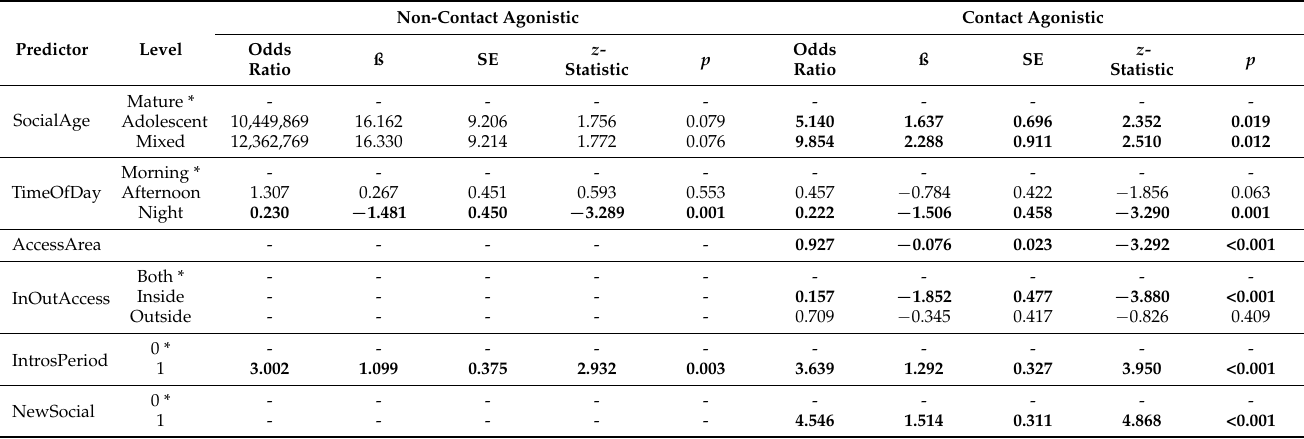
Table A8. Mature GLMER model parameter estimates for agonistic response variables. Generalized linear mixed-effect model results of associations between predictor variables (fixed effects) and behavioral response variables for mature focal animals. ß = Beta coefficients from model outputs: positive values indicate an increase in odds compared to the reference level while negative values indicate a decrease in odds compared to reference level; SE = standard error of beta coefficients; Wald X 2 = Chi-squared statistic from Wald test with df = 1; p = p -value from Wald test. * indicates reference level. Bold signifies statistical significance ( p < 0.05).